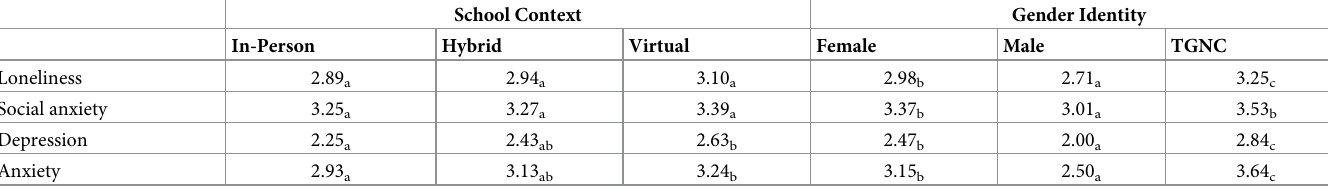
gender identity variables, as there were no significant school context by gender interactions. Exact p -values are reported in the text. Results after controlling for age, parent education, participant ethnicity, and virtual school